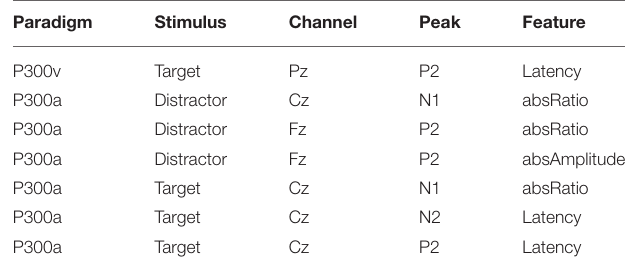
TABLE 3 | Features selected by the Boruta feature selection